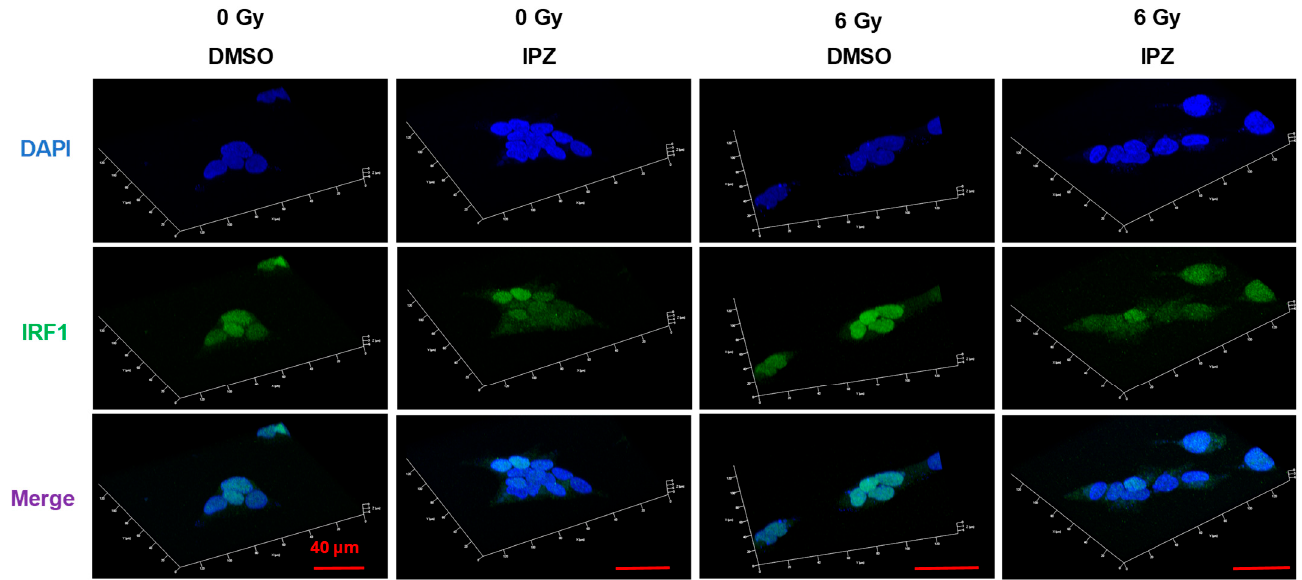
Figure 2. Involvement of IRF1 in radiation-increased PD-L1 expression in Ca9-22 and A549 cells. ( A ) Ca9-22 and A549 cells transfected with control or IRF1 siRNA were harvested for western blot analysis. An image of a representative immunoblot is shown. GAPDH was used as a loading control. ( B , C ) IRF1-knockdown Ca9-22 ( B ) and A549 cells ( C ) were irradiated with 6 Gy and cultured for 4 days. After culturing, the cells were harvested for analysis of cell surface PD-L1 expression. ** p < 0.01.